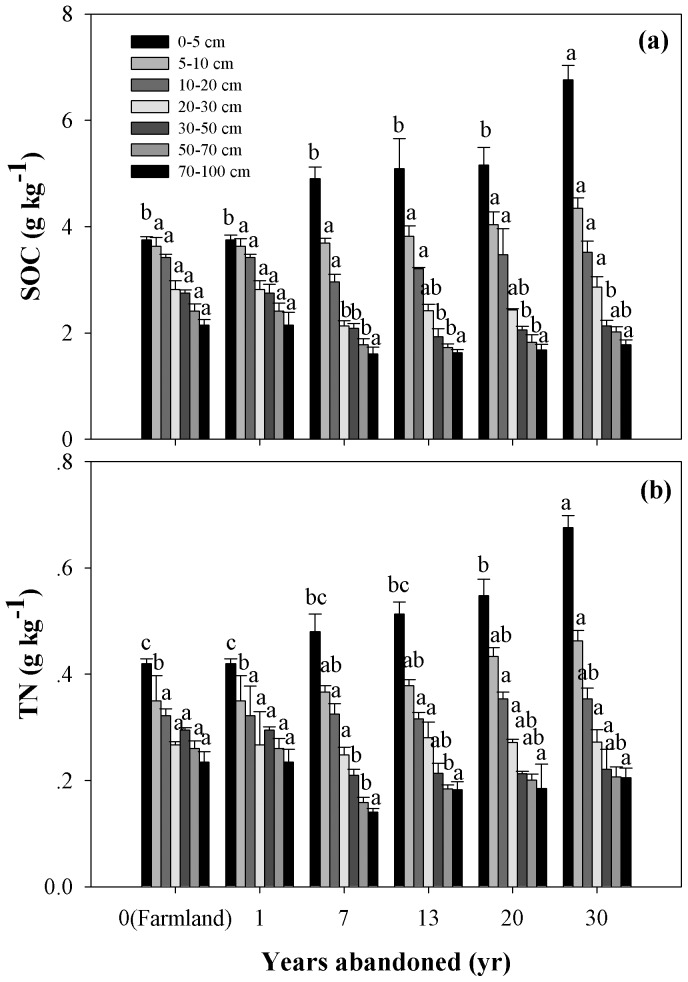
SOC and TN dynamics for seven soil layers of 0–100 cm following the conversion of farmland to grassland.Values are in the form of Mean ± SE and the sample size n = 5. Different lower-case letters above the bars mean significant differences in the same soil layers among abandoned land in different years (P<0.05).